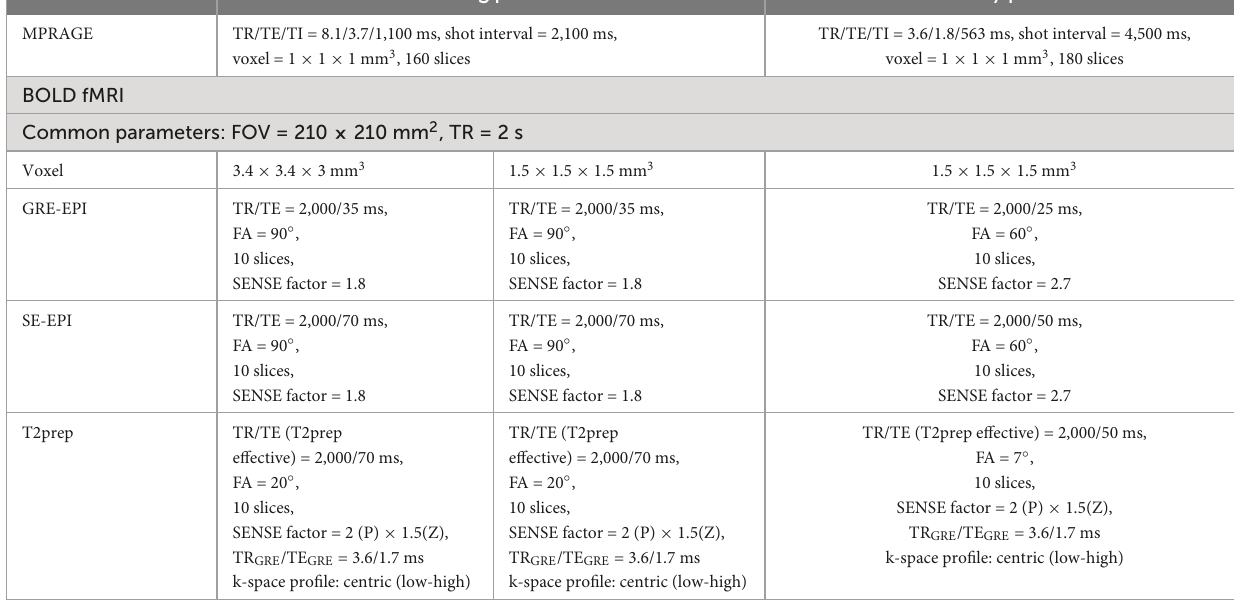
TABLE 1 Imaging parameters in all magnetic resonance imaging (MRI) sequences used in this study.